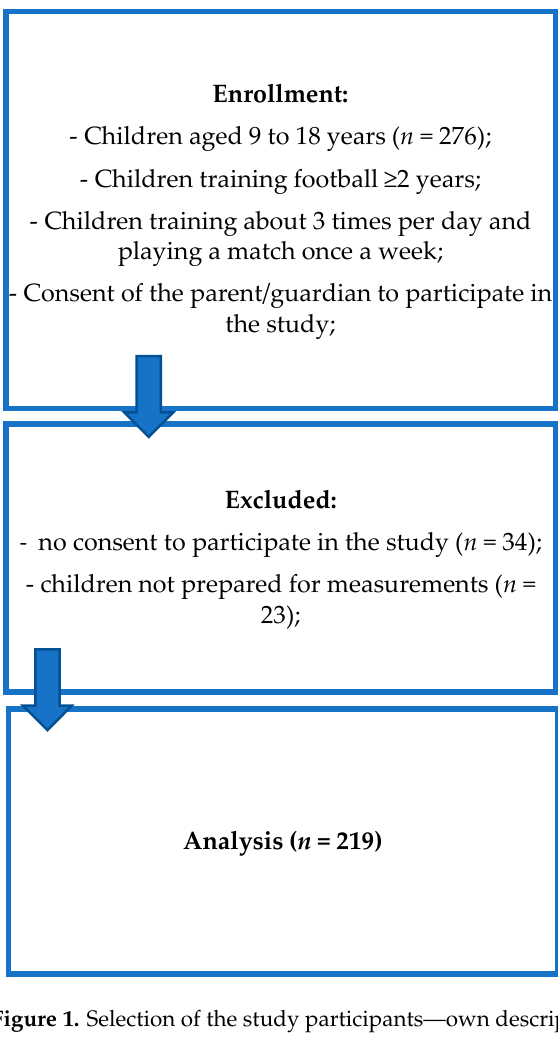
Figure 1. Selection of the study participants—own description.